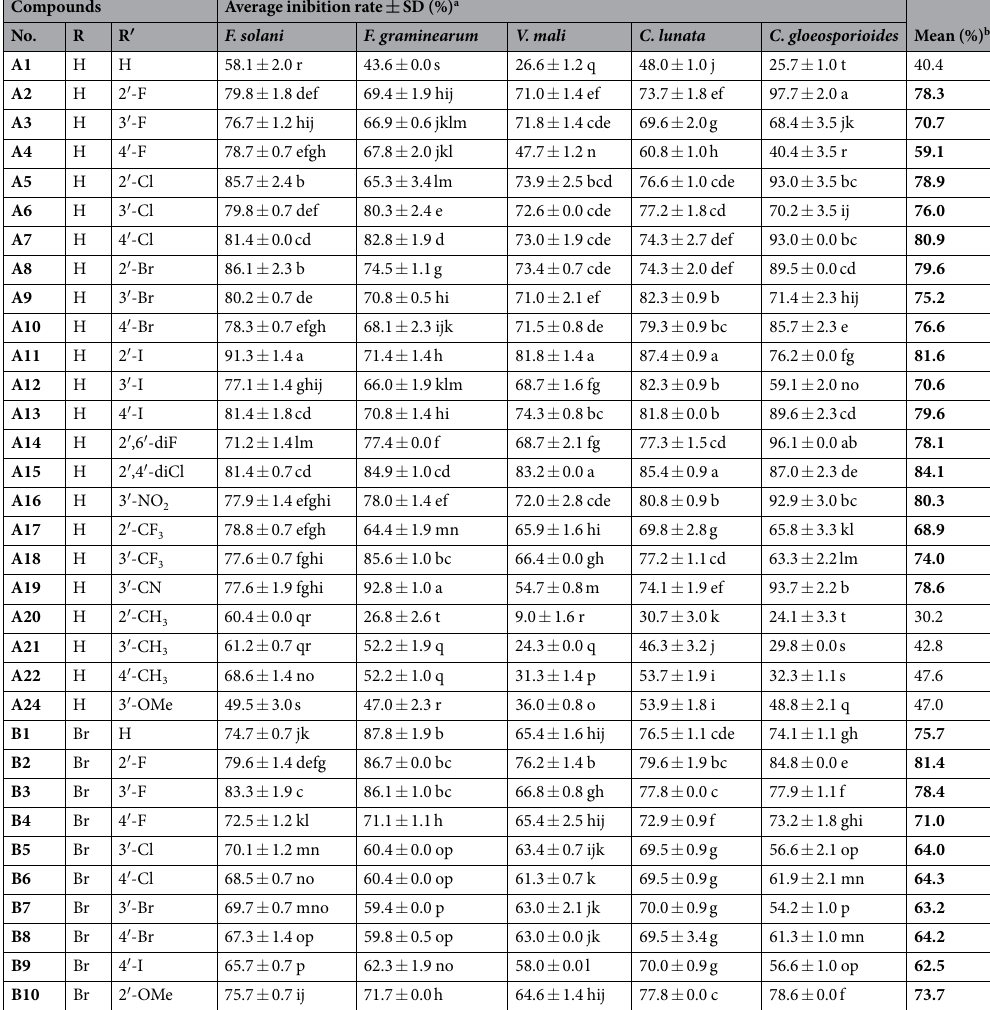
Table 2. Antifungal activity of compounds A and B at 75 μ M. a The difference between the data with the different lowercase letters within a column is significant ( P < 0.05). b Mean: the average values of inhibition rates of the same compound on the five test